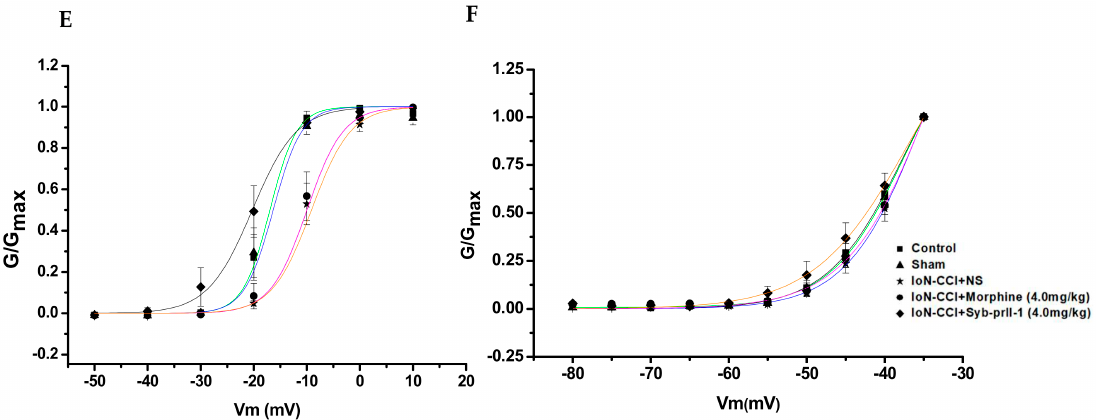
Figure 6. Changes in Nav1.8 and Nav1.9 current I ‐ V curves and steady ‐ state activation curves in TG neurons after IoN ‐ CCI treatment and Syb ‐ pr Ⅱ ‐ 1 injection. ( A ) A series of Nav1.8 currents recorded in the presence of 1000 nM TTX. Cells were depolarized to a variety of potentials ( − 50 mV to +50 mV) from a holding potential of − 100 mV to elicit Nav1.8 currents ( n = 9). ( B ) I ‐ V curves of Nav1.8 currents. ( C ) A series of Nav1.9 currents recorded in the presence of 1000 nM TTX. Cells were de ‐ polarized to a variety of potentials ( − 80 mV to − 35 mV) from a holding potential of − 100 mV to elicit Nav1.9 currents ( n = 9). ( D ) I ‐ V curves of Nav1.9 currents. ( E ) Changes in the steady ‐ state activation curves of Nav1.8 in TG neurons. IoN ‐ CCI surgery shifted the steady ‐ state activation curve in a de ‐ polarization direction; 4.0 mg/kg Syb ‐ pr Ⅱ ‐ 1 shifted the steady ‐ state activation curve in a hyperpo ‐ larizing direction ( n = 9). ( F ) Changes in the steady ‐ state activation curves of Nav1.9 in TG neurons IoN ‐ CCI surgery shifted the steady ‐ state activation curve in a depolarization direction; 4.0 mg/kg Syb ‐ pr Ⅱ ‐ 1 shifted the steady ‐ state activation curve in a hyperpolarizing direction ( n = 9).